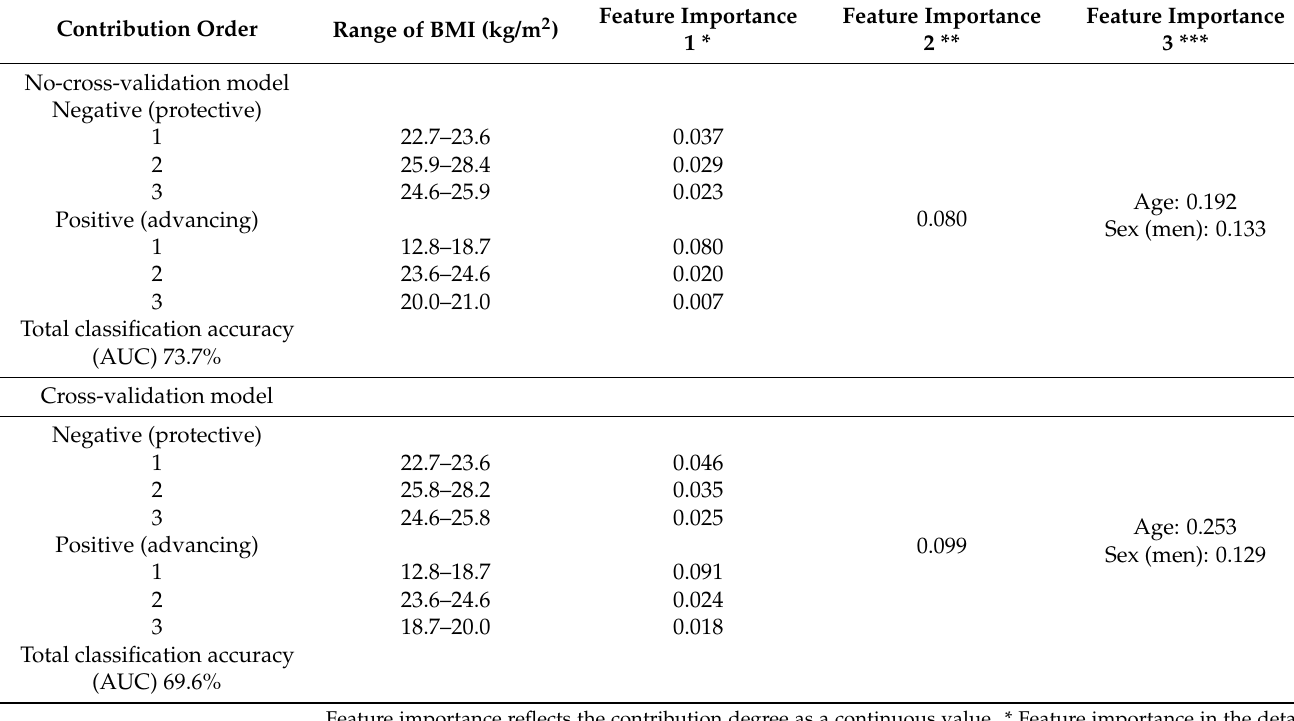
Table 2. Adjusted contributions of the ranges of BMI toward all-cause mortality.